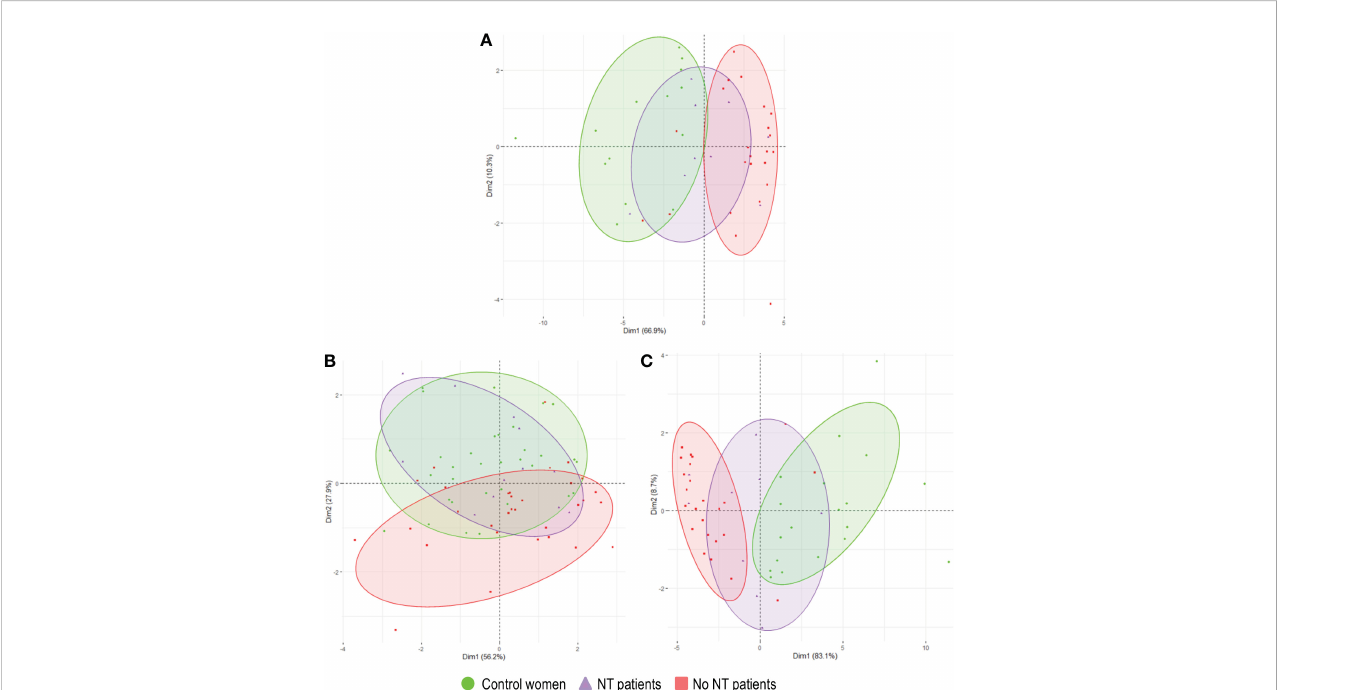
FIGURE 5 Principal component analyses comparing the levels of the 5 NETosis biomarkers in peritoneal fl uid (PF) and plasma samples between control women (n=21 and n=40, respectively), patients with high-grade serous ovarian cancer (HGSOC) who recived neoadjuvant treatment (NT) (n=9 and n=13, respectively) and who did not (n=26 and n=32, respectively). (A) NETosis biomarkers in both bio fl uids, (B) in plasma, and (C) in PF. Dim,